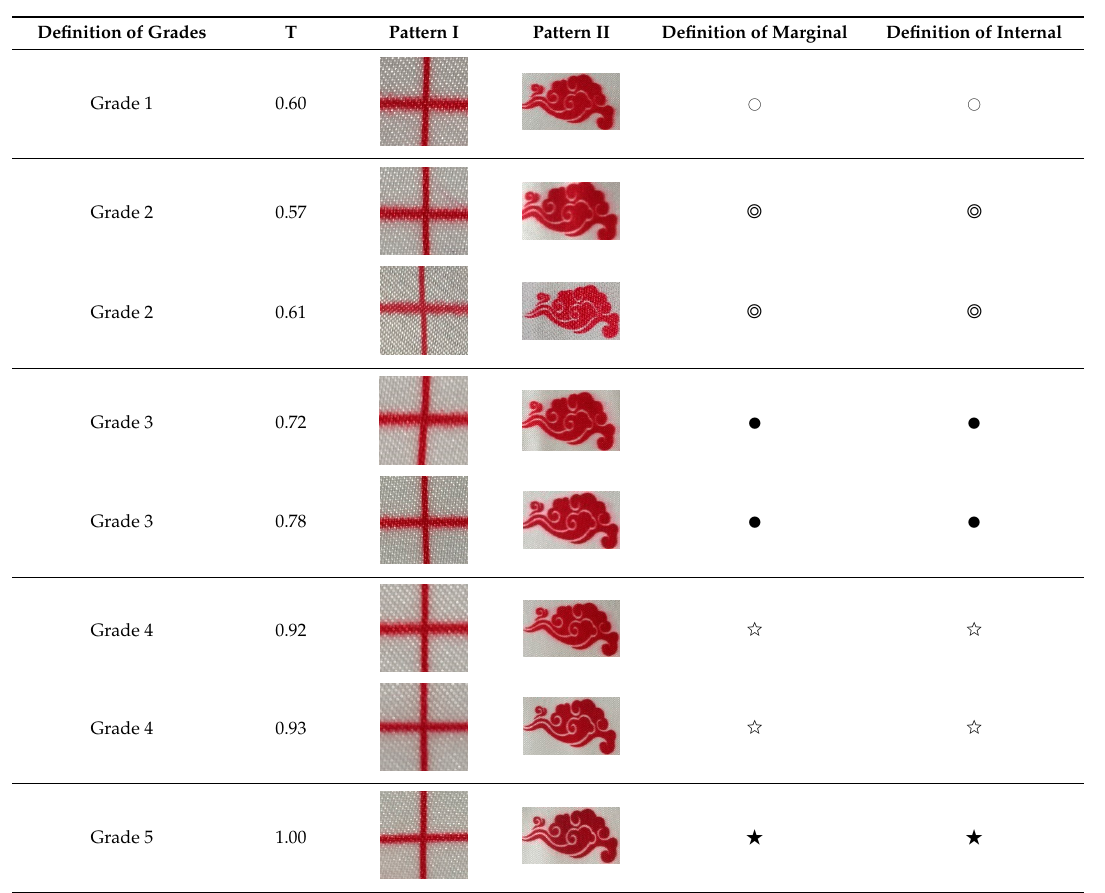
Table 3. Results of the ink drop experiment, grade of definition and pattern of actual printing.